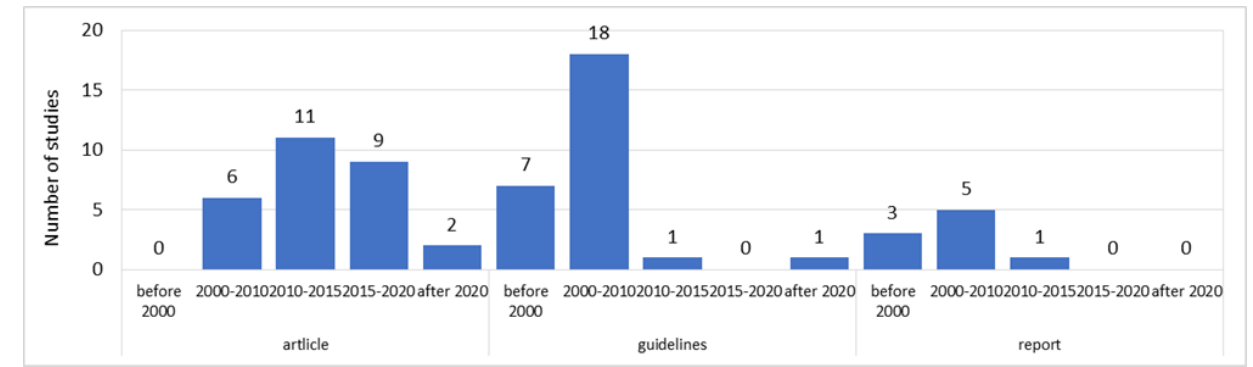
Figure 1. Progress of studies related to this issue.